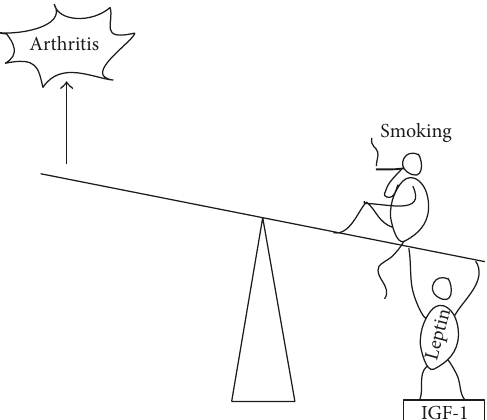
Figure 3: Graphic summary. The combined results obtained on patients with early RA (the Leiden cohort, 𝑛 = 193 ) and on patients with established and treated RA (the Gothenburg cohort, 𝑛 = 350 ) indicate that cigarette smoking may be a major cause of acquired IGF1 and leptin deficiency in RA. The multivariate analysis confirmed an association between smoking, IGF1, and leptin, where hypoleptinemia was also shown to be a consequence of higher disease activity. These novel associations are of potential importance for long-term prognosis and in risk assessment for complications and comorbidities in